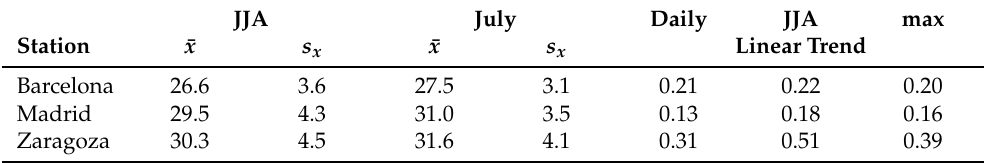
Table 2. Left: mean ¯ x and standard deviation s x of daily maximum temperatures in JJA and July. Right: linear trend ( ◦ C/decade) in daily series, daily series of JJA, and annual maximum temperatures. JJA